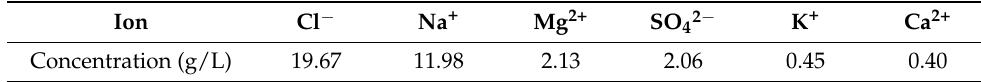
Table 2. Ion concentration of